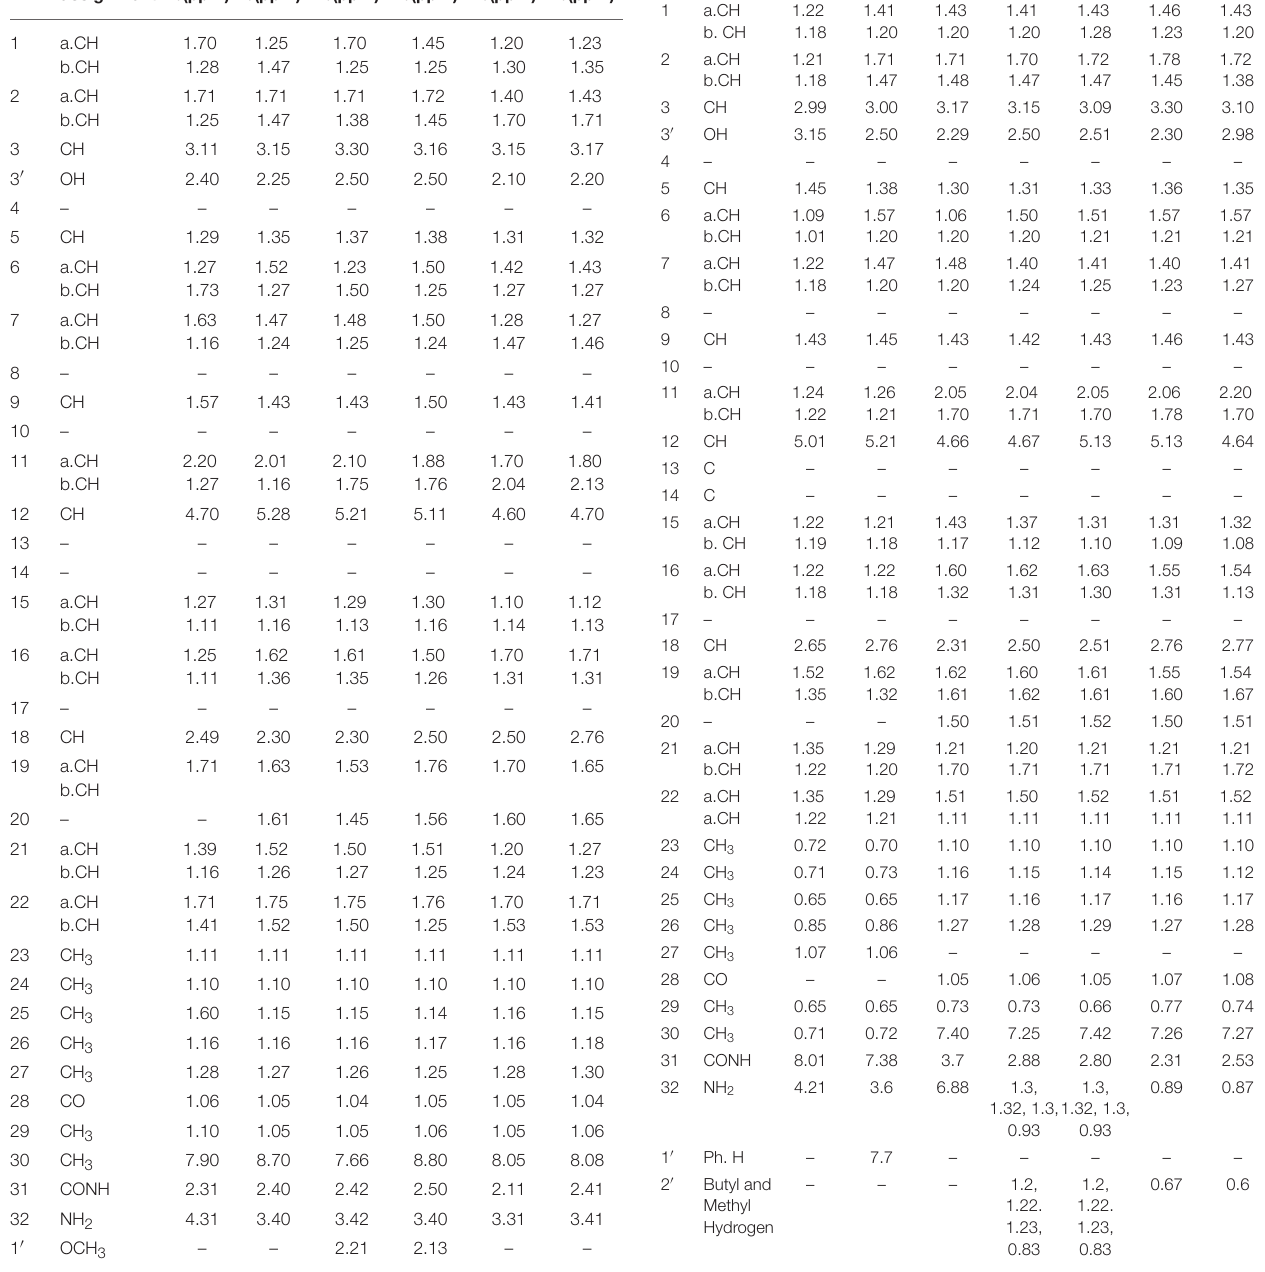
TABLE 4B | 1 HNMR spectral data of ligand and their metal (Tin) complexes.